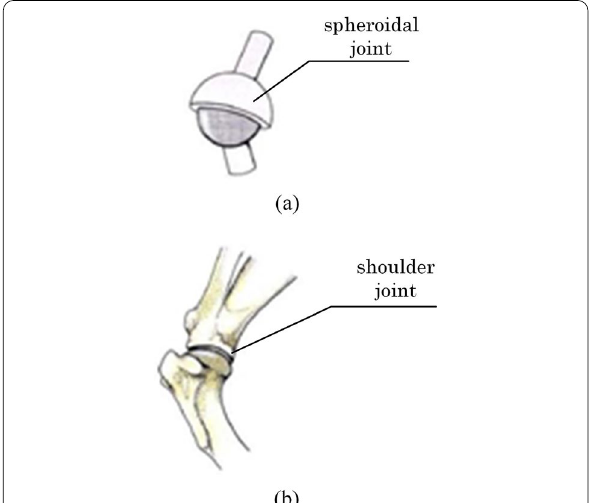
Figure 10 Shoulder joint of a ruminant: a structural sketch of the equivalent spheroidal joint, b physical structure sketch of the shoulder joint